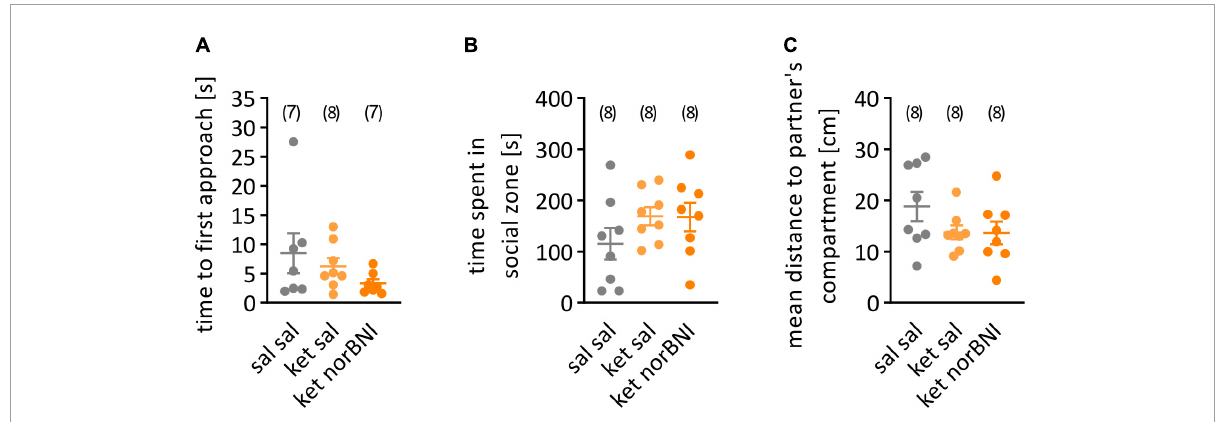
FIGURE3 Social interaction in partition test. (A) time to first approach, (B) time spent in social zone, (C) mean distance to partner’s compartment. “Sal sal” corresponds to treatment with saline throughout the procedure, “ket sal” represents subchronic ketamine treatment and then saline injection before the test, and “ket norBNI” is ketamine treatment followed by single injection of norbinaltorphimine. The lines represent the mean and SEM. The numbers above the graphs indicate group